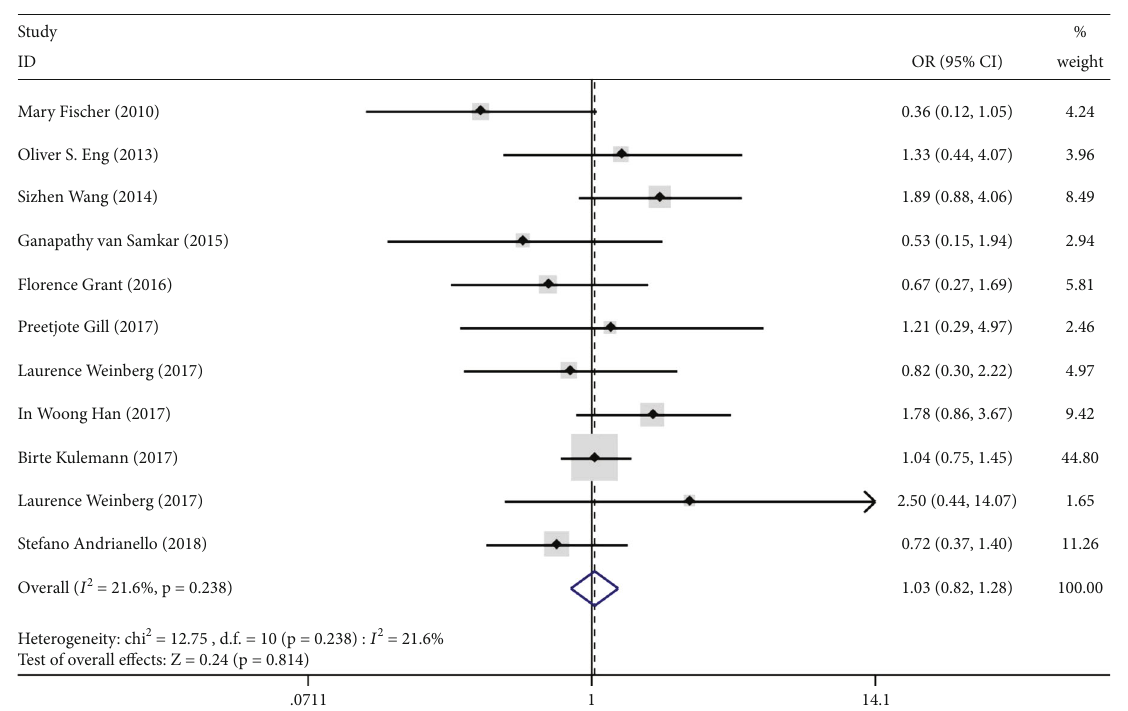
Figure 4: Forest plot for pancreatic fi